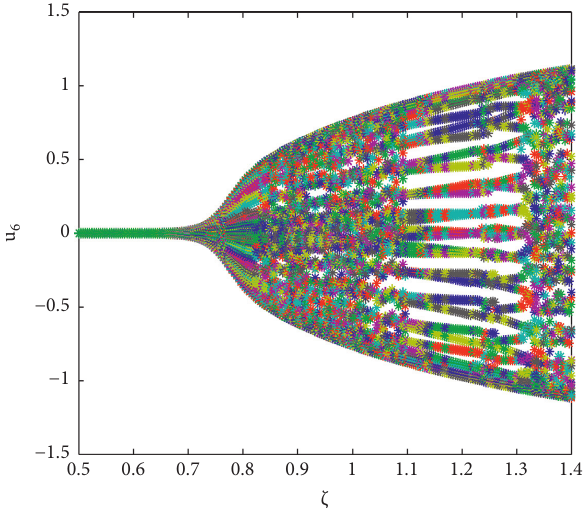
Figure 8: Bifurcation figure of neural network model (46): ζ - u